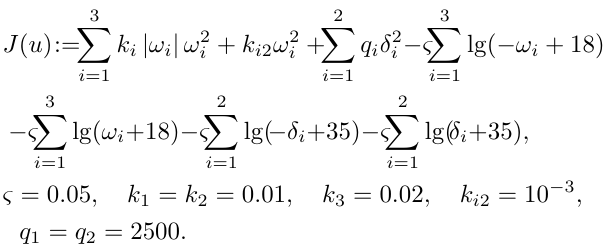
Figure 2: Desired (dashed) and actual ship positions (solid).